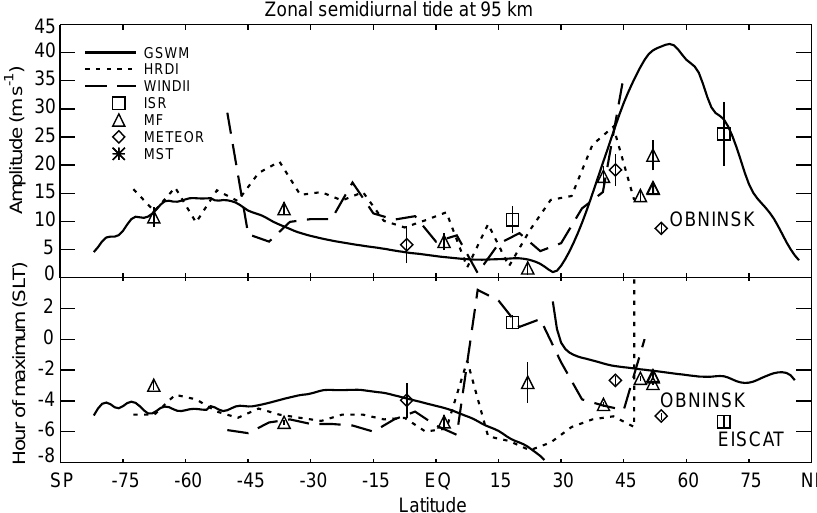
Fig. 6. A latitude cross section of the zonal semidiurnal tide at 95 km. The top panel shows the tidal amplitude and the bottom panel shows the tidal phase. The key for the plot is the same as for